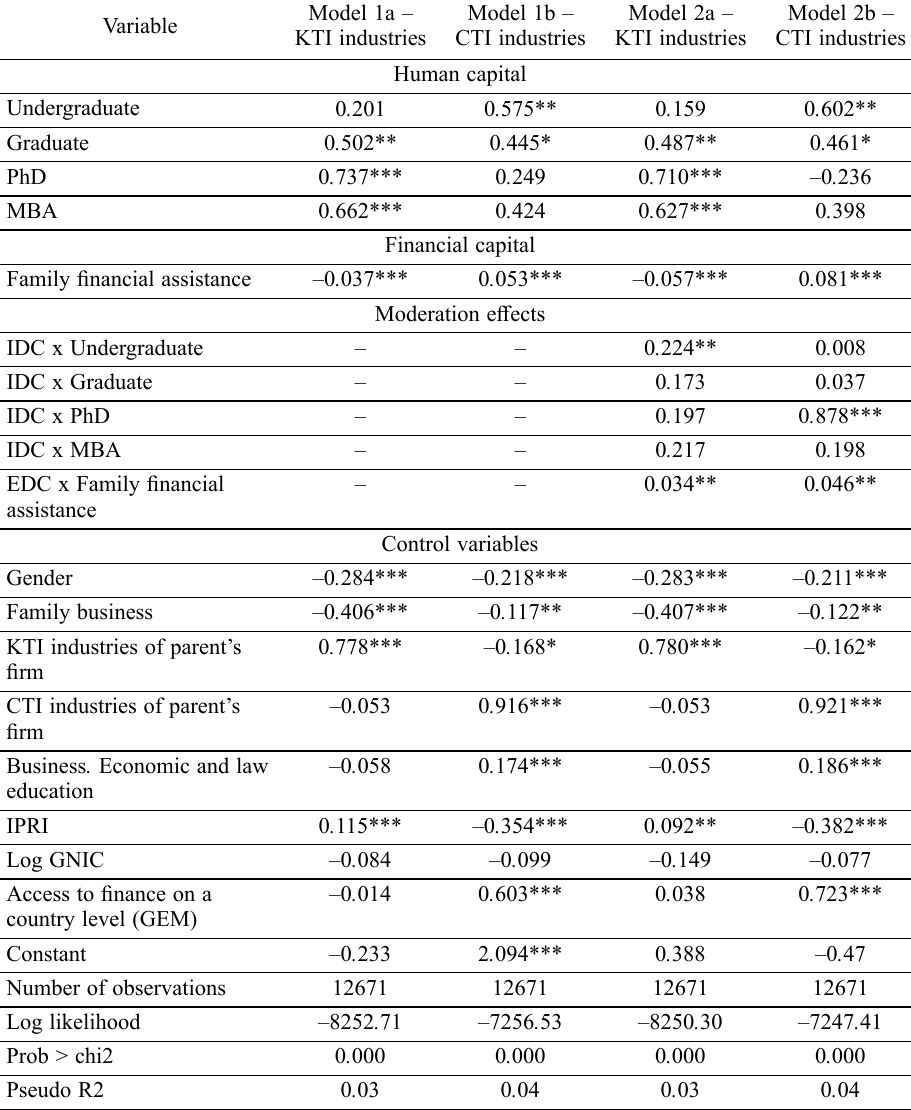
Table 2. Estimation